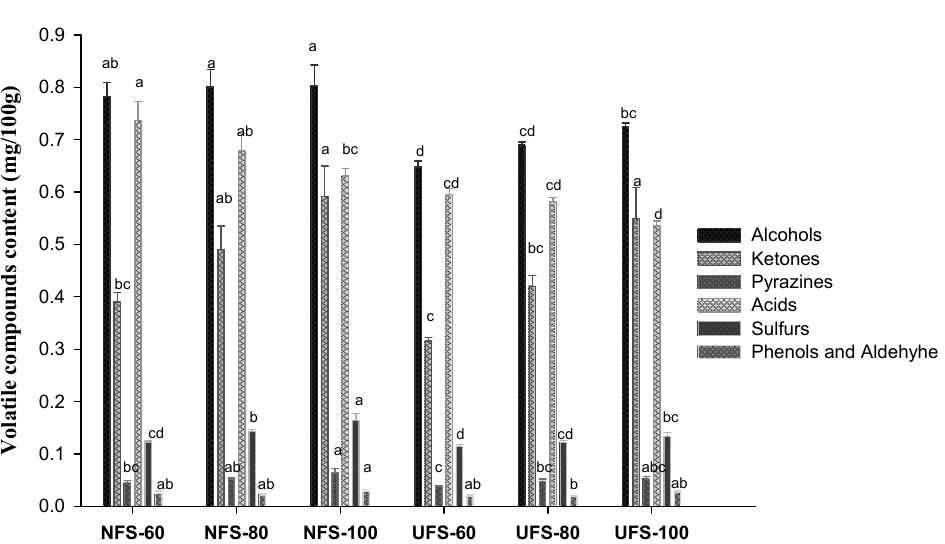
Figure 2. Volatile compounds content of aroma component groups of palmyra palm syrups prepared by thermal and ultrafiltration processes. Data are mean ± SD from triplicate experiments.